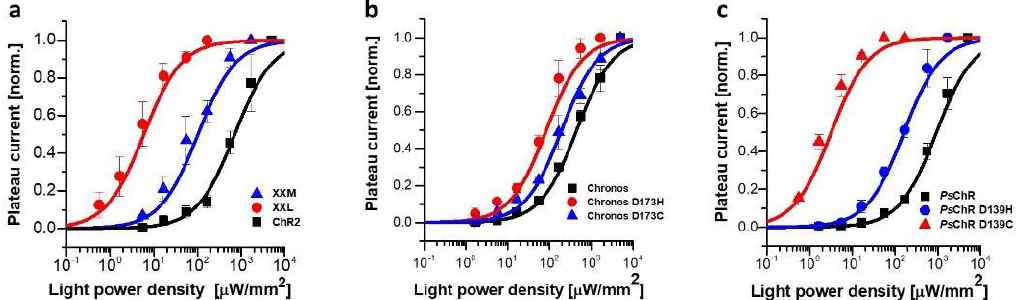
Closing time (ms) EPD 50